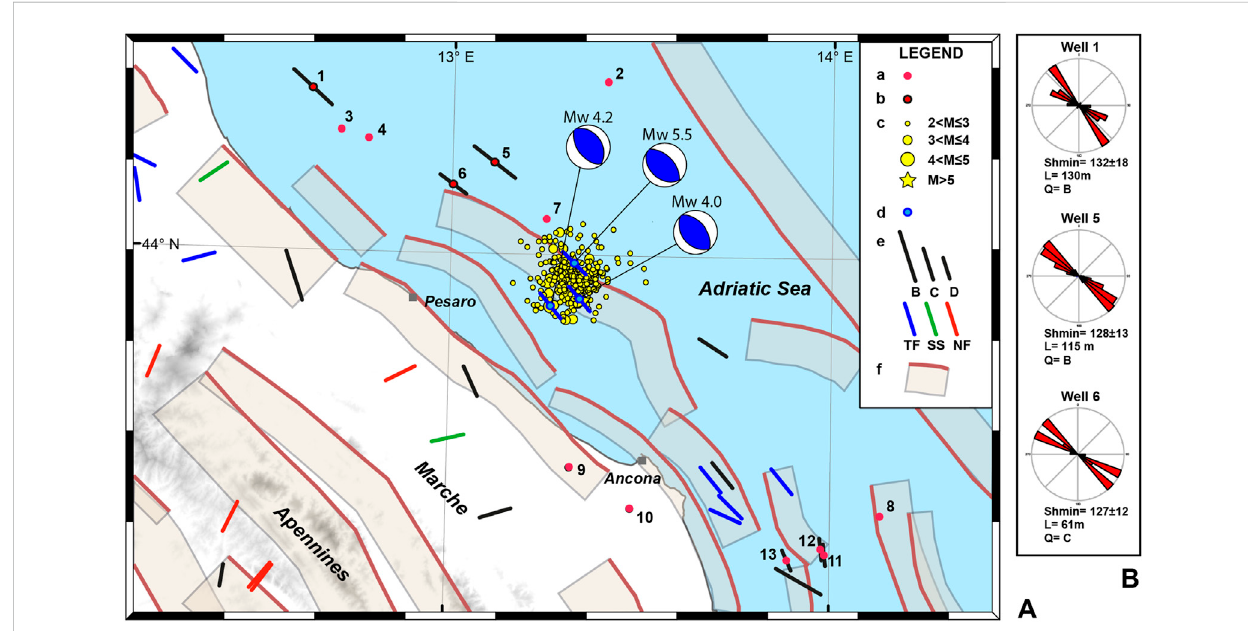
FIGURE 1 (A) Study area and results of contemporary stress analysis. Legend: a) Borehole data analysed in this study (number 1 – 13). b) Sh min orientations obtained in this work from the analysis of borehole breakouts (number 1, 5 and 6). c) Earthquakes with M > 2 of the 2022-2023 Adriatic seismic sequence only from 9th to 23rd November (ISIDe working group, 2007; http://terremoti.ingv.it/). d) Sh min orientations obtained in this work from focal mechanism data of M > 4 earthquakes (available on 10 February 2023). e) Sh min orientations scaled by quality (B, C, D, from the best to the worst) from the database of the Italian Present-day Stress Indicators, IPSI 1.5 (Mariucci and Montone, 2022): black bars are relative to borehole breakout data (unde fi ned tectonic regime); colour barsare relativeto focal mechanismdata and indicate thetectonic regime (TF, thrustfaulting;SS, strike-slip faulting; NF, normal faulting). f) Composite seismogenic sources from the Database of Individual Seismogenic Sources (DISS Working Group, 2021). (B) Rose diagrams of